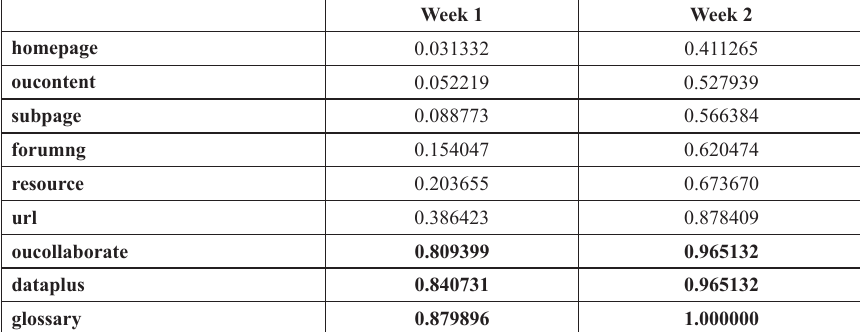
Table 4. Analysis of missing